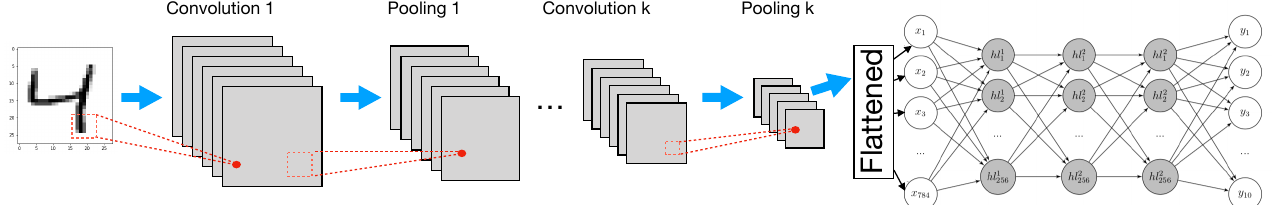
Figure 4. CNN architecture. The input data are introduced into a convolutional layer (accounting for different convolutional filters to generate feature maps, that accentuate the unique features of the original image) followed by a pooling layer (that reduces the size of the image combining neighboring pixels of a certain image area into a single representative value). Multiple sets of convolutional + pooling layers can be applied as pre-processing. Finally, all outputs of the last pooling layer are flattened (from a matrix to an array) and used as inputs of a